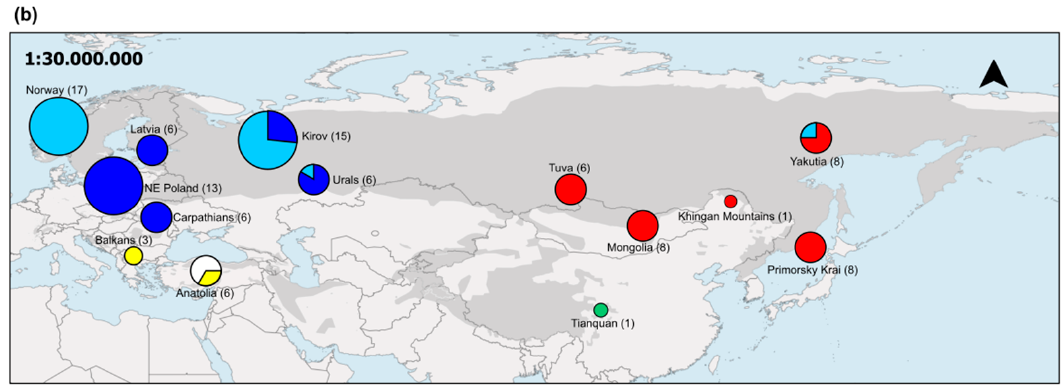
Figure 3. Relationships among L. lynx mitogenomes and their geographic distribution. ( a ) Median-joining network of L. lynx mitogenome haplotypes. Each circle represents a haplotype, with the circle size indicating the number of individuals sharing that haplotype. Black dots (vectors) were introduced by the network constructing algorithm and represent haplotypes not sampled. Dashes along lines that connect haplotypes indicate the number of nucleotide differences between haplotypes. Coloring of lineages follows Figure 2. Diamond-shaped symbols indicate the most recent common ancestors (MRCA), white: MRCA of all clades, red: MRCA for lineages. The white star in lineage C1 indicates the L. l. carpathicus -specific haplotype. ( b ) Geographic distribution of L. lynx mitogenomes across the Palearctic region. Coloring of circles follows Figure 2 and indicates clade/lineage assignment, circle size indicates number of individuals included. The figure was adapted from Lucena-Perez et al. [18] and extended to include L. l. dinniki (Anatolia, n = 6), L. l. wrangeli from China (Khingan Mountains, n = 1 [47]), and L. l. isabellinus (Tianquan, n = 1 [38]).